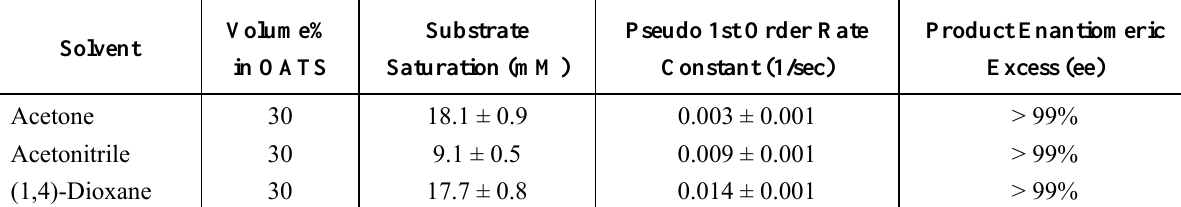
Table 4. Kinetic Parameters for CAL B Kinetic Resolution of rac -1-phenylethyl acetate to (R)- 1-phenylethanol at room temperature